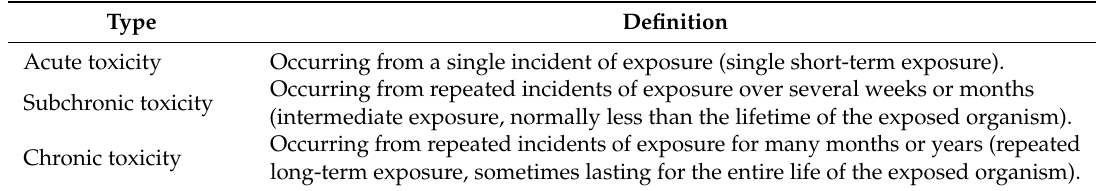
Table 1. Types of toxicity based on the extent of exposure to a pesticide [23].